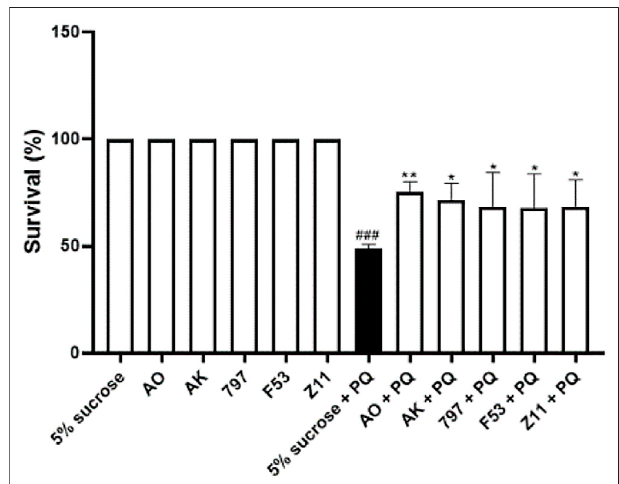
FIGURE 2 | Identi fi cation of neuroprotective compounds in the PQ- induced oxidation model. 5% sucrose + 6 mg/ml PQ vs. 5% sucrose, ### p < 0.001, PQ at this concentration can have a lethal effect on Drosophila .; AO+ 6 mg/ml PQ vs. 5% sucrose + 6 mg/ml PQ, ** p < 0.01; AK + 6 mg/ml PQ vs. 5% sucrose + 6 mg/ml PQ, * p < 0.05; 797 + 6 mg/ml PQ vs. 5% sucrose +6 mg/mlPQ, * p < 0.05; F53 + 6 mg/ml PQvs. 5% sucrose + 6 mg/ mlPQ,* p < 0.05;Z11+6 mg/mlPQvs.5%sucrose+6 mg/mlPQ,* p < 0.05; This result demonstrated that these fi ve compounds had antioxidant